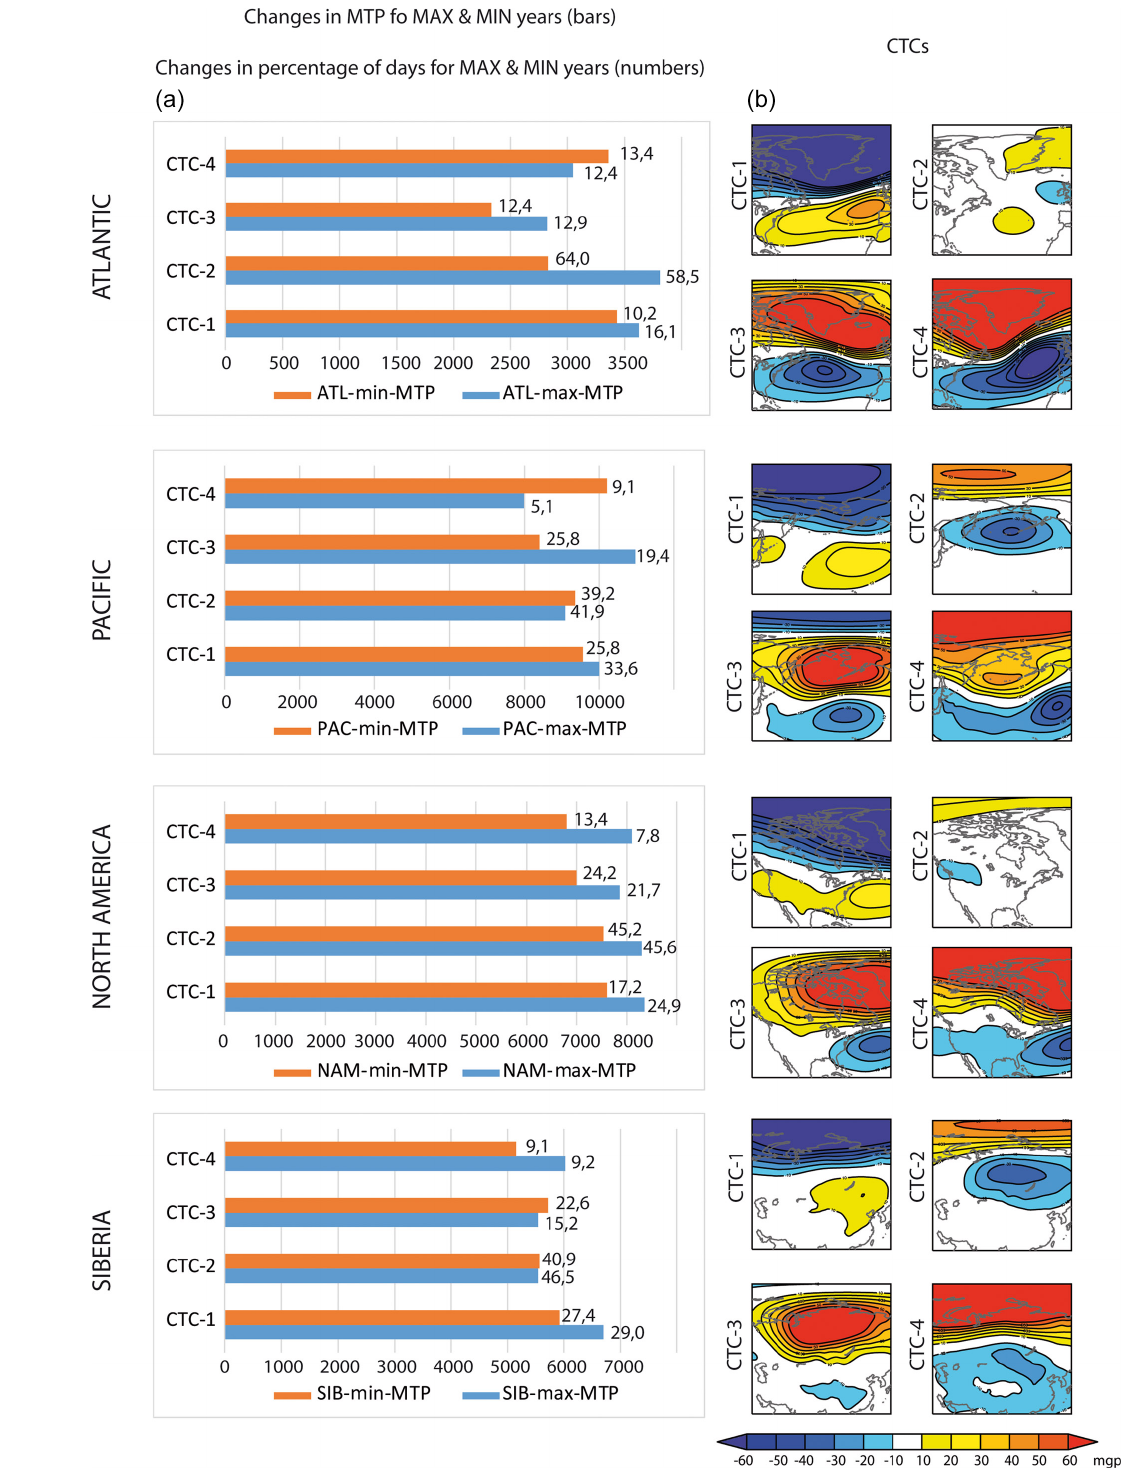
Figure 6. (b) Anomalies of geopotential height at 850hPa (Z850) for the four types of circulation centred in the four source sectors (classes CTC1 to CTC4) for spring and associated with (a) the average MTP and percentage of occurrence for each CTC for minimum SIE years (orange bars) vs. the maximum (blue bars) in May. The number associated with each of the bars represents the percentage of occurrence for each circulation type (CTC) for minimum vs. maximum SIE years for May